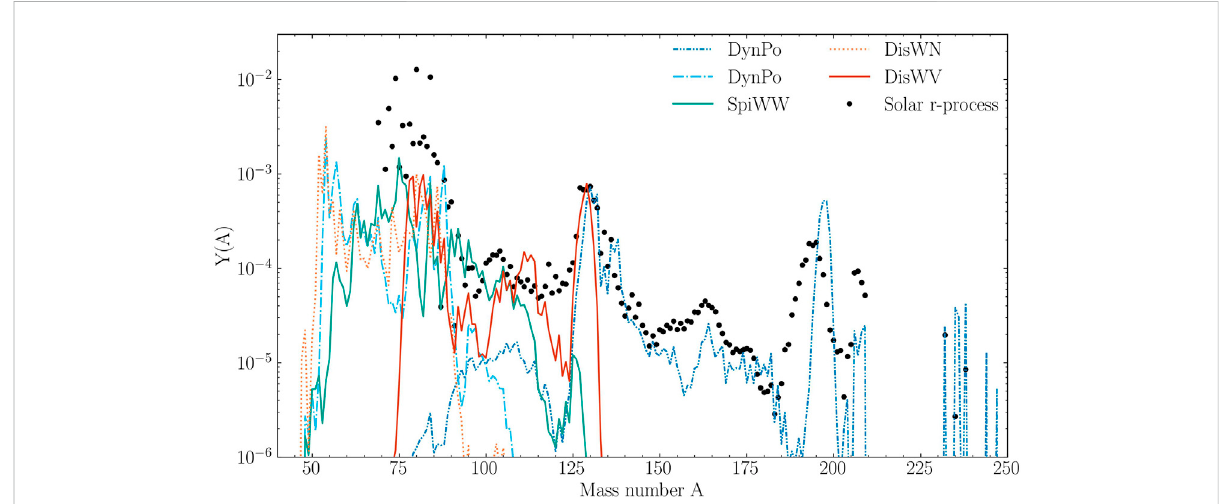
FIGURE 1 Final abundances Y ( A ) versus mass number A for the fi ve parameterized baseline astrophysical trajectories representative of the different NSM ejecta channels described in the text: matter dynamically ejected during the merger at equatorial (DynEq) and polar (DynPo) angles (blue and cyan lines, respectively), and winds expelled after the merger due to the propagation of spiral arms in the NS remnant (SpiWW; green line), neutrino irradiation (DisWN; orange line), and viscous processes (DisWV; red line). The scaled solar r-residuals, obtained by multiplying the solar system abundances of Lodders (2021) by the r-fractions from Prantzos et al. (2020), are shown for comparison.